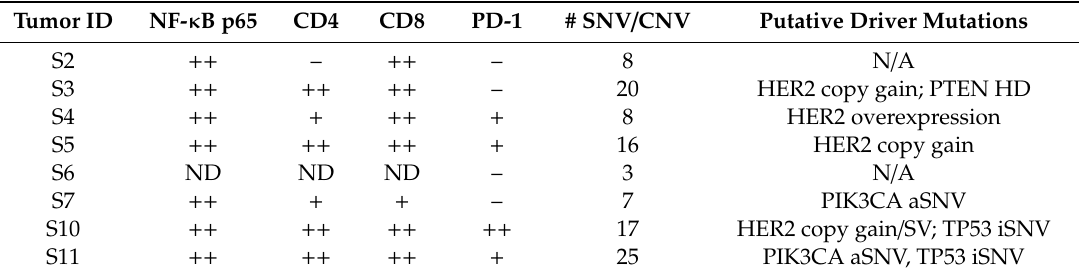
Table 2. Summary of Immunohistochemistry (IHC) markers and putative driver mutations. Tumor ID